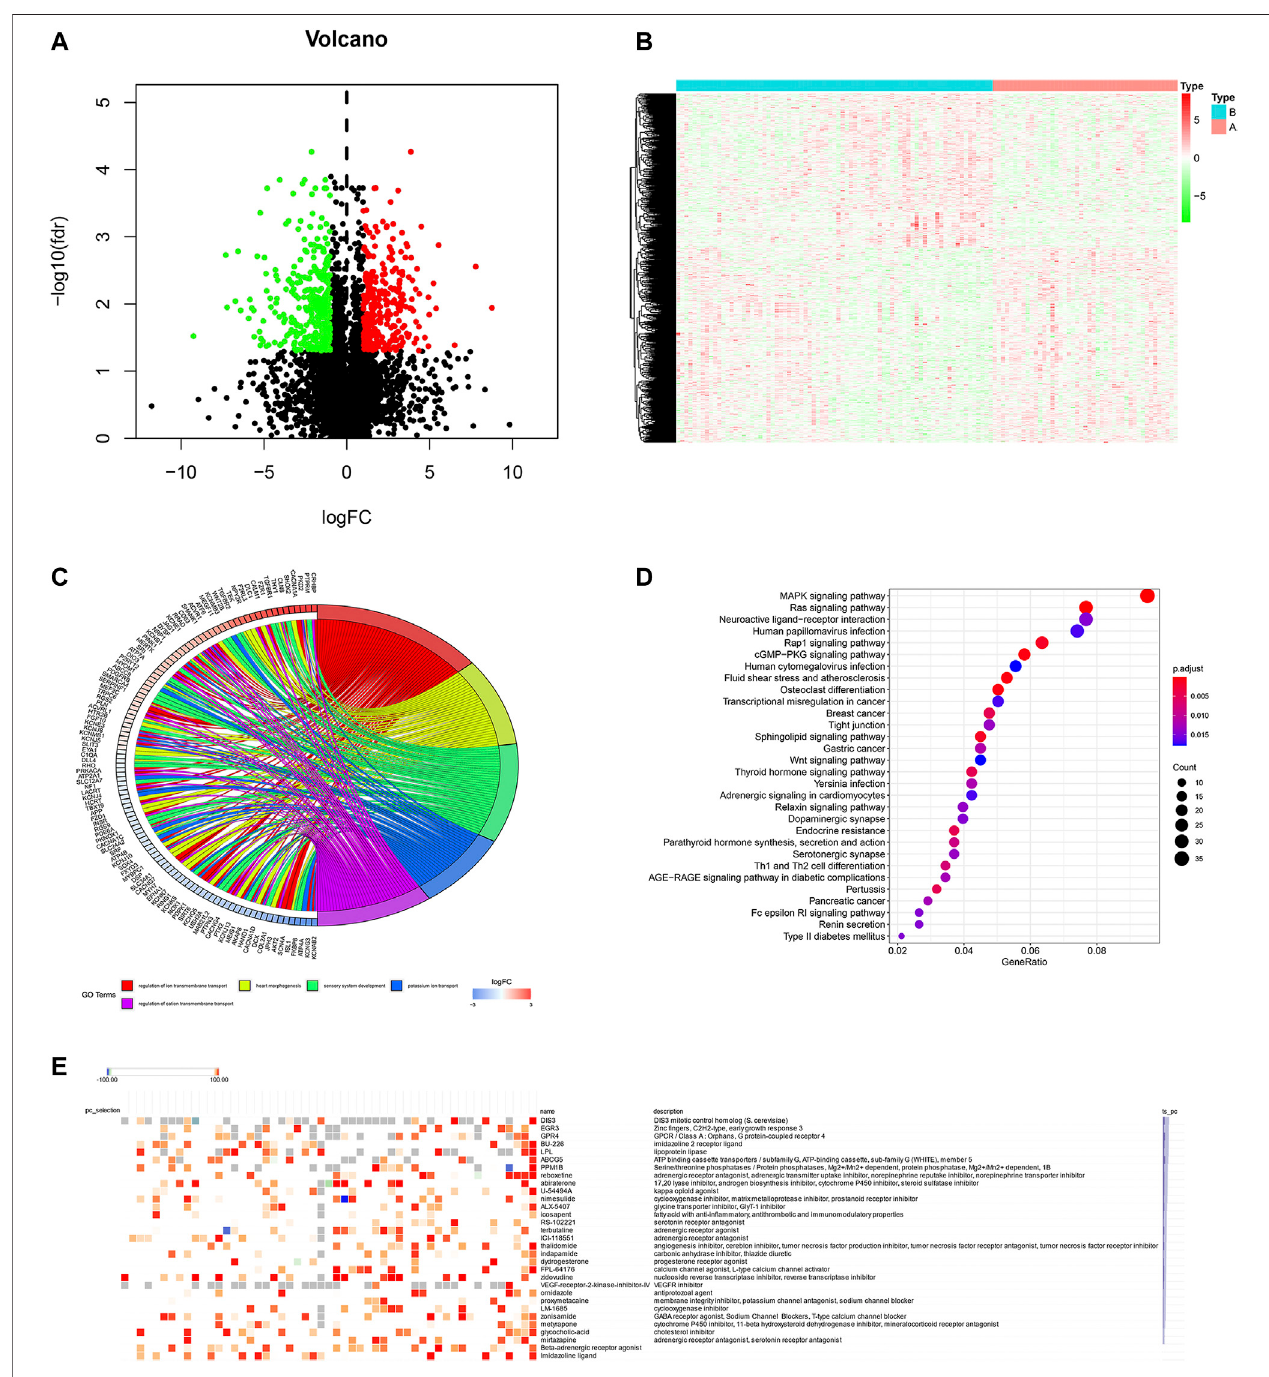
FIGURE 9 | Potential small molecule compounds based on the ferroptosis. (A) The volcano plot demonstrated the up-regulated genes (red dots) and down- regulated genes (green dots). (B) Heatmap showed the SDG expression pro fi les between high- and low-ferroptosis score groups. (C) GO circle plot showed the enrichmentanalysisresultsrankedbylogFCandFDR. (D) KEGGenrichmentanalysisrevealedthepossiblepathwaysandmechanisms. (E) Smallmolecularcompounds and possible mechanisms. The results were downloaded from the CMap website.